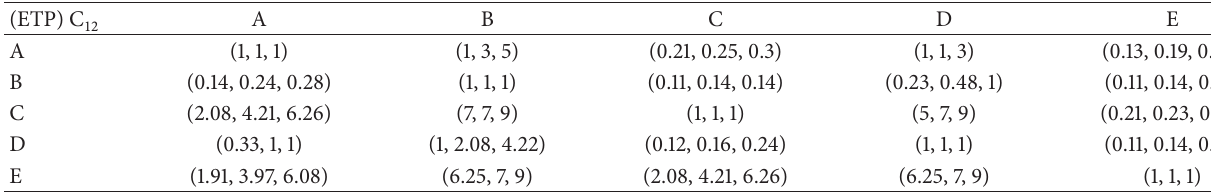
Table 5: Options concerning the ETP subcriteria.